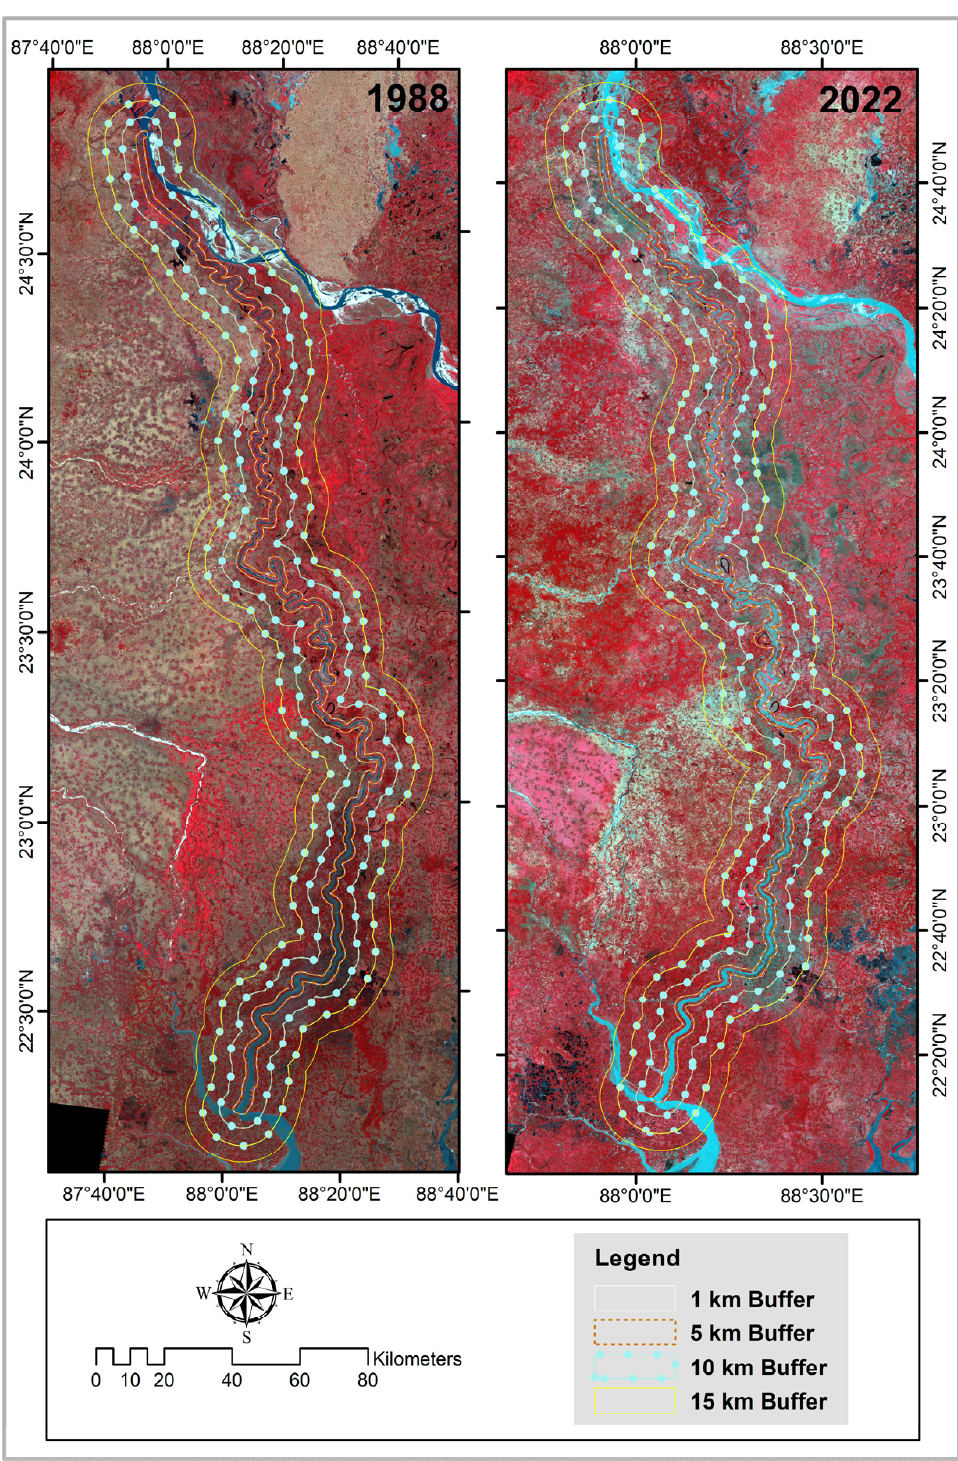
Figure 2. Landsat-5 TM and Landsat-8 OLI for 1988 and 2022.